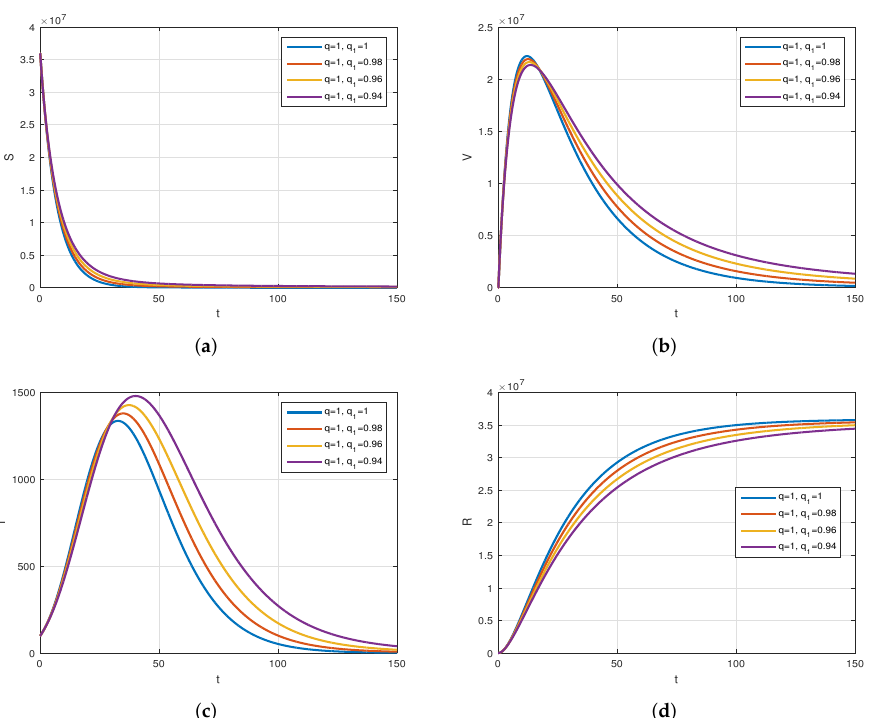
Figure 4. The plot display the behavior of the model for various values of q 1 and q = 1. Subfigure ( a ) shows the simulation of healthy population when fixing q and varying q 1 . Subfigure ( b ) shows the simulation of vaccinated population when fixing q and varying q 1 . Subfigure ( c ) shows the simulation of infected population when fixing q and varying q 1 . Subfigure ( d ) shows the simulation of recovered population when fixing q and varying q 1